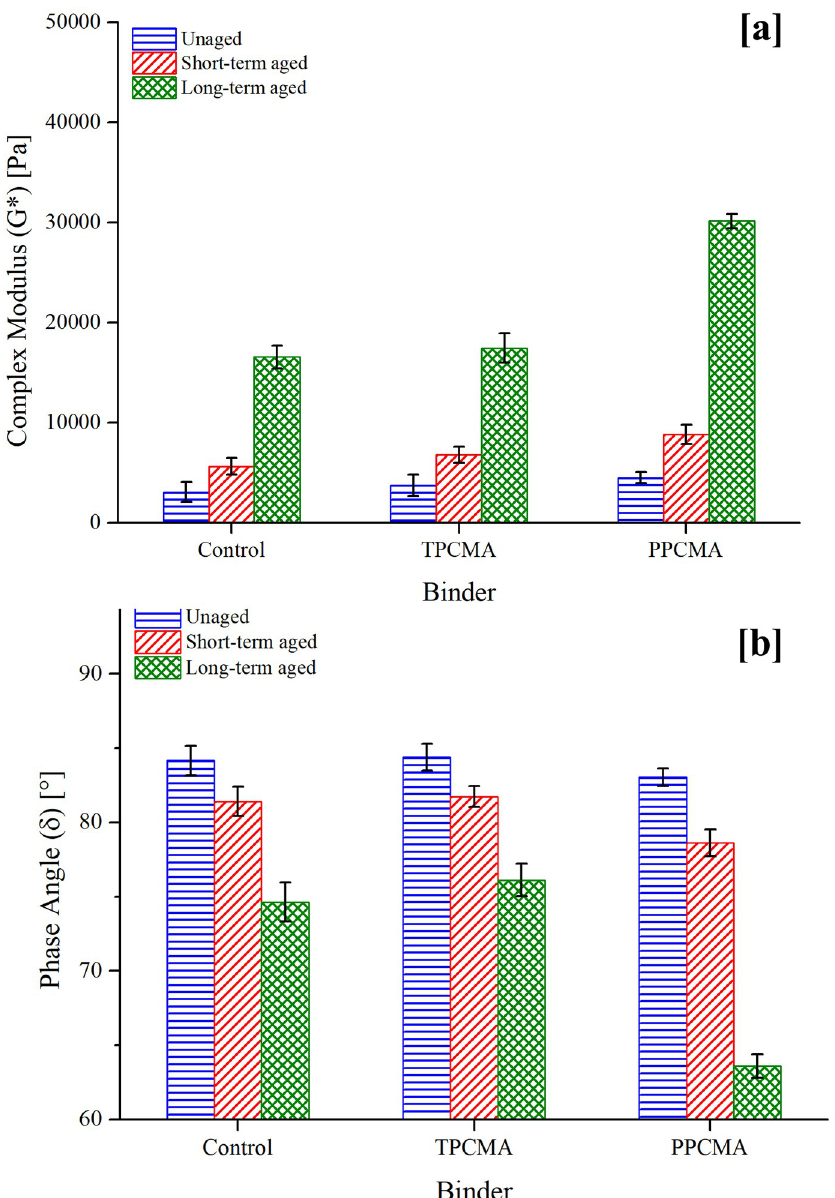
Fig 4. Frequency sweep result at 10 rad/s (a) G � (b) δ